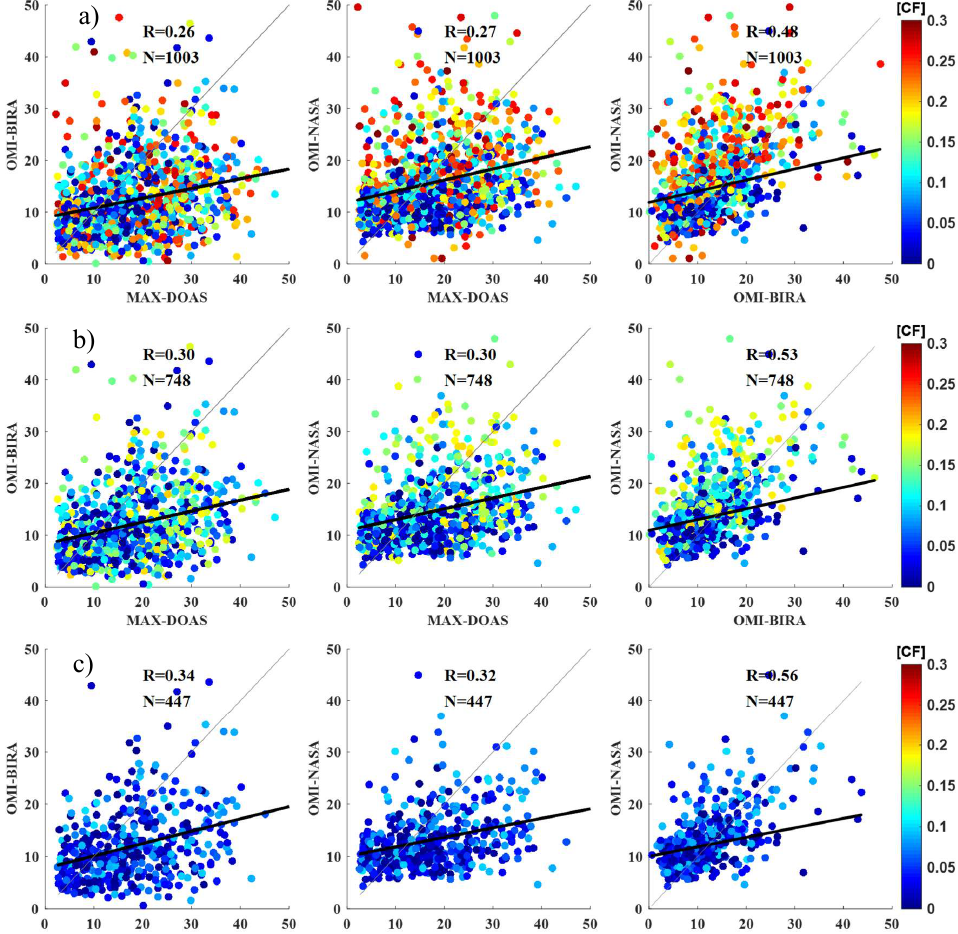
Figure 3. Daily comparisons of OMI-BIRA and MAX-DOAS, OMI-NASA and MAX-DOAS, and OMI-NASA and OMI-BIRA: ( a ) 0 ≤ eCF ≤ 30%, ( b ) 0 ≤ eCF ≤ 20%, ( c ) 0 ≤ eCF ≤ 10%. Figure A1 to Figure A3 show daily comparisons between OMI-BIRA and MAX-DOAS, OMI-NASA and MAX-DOAS, and OMI-NASA and OMI-BIRA by season. Figure A1 shows that the correlation between OMI-BIRA and MAX-DOAS is the best in spring, with R = 0.25 (R = 0.26) for 0 < eCF < 0.2 (0 < eCF < 0.1). The changes in eCF can change the correlation between the satellite data and the MAX-DOAS observations when the upper limit of eCF changes from 0.3 to 0.2 for all seasons except winter; however, less variation is observed for stricter cloud screening (eCF < 0.1) for summer. In winter, there is a weak correlation or even a negative correlation between OMI-BIRA and MAX-DOAS, indicating that the winter satellite data need to be used cautiously. Figure A2 shows that OMI-NASA has a better correlation with MAX-DOAS in spring. When stricter eCF control is employed, the satellite dataset’s correlation with the ground observations can be improved for spring and summer, but the two datasets have a poor correlation in summer and winter. OMI-NASA and OMI-BIRA have similar correlations except for winter, with R values ranging from 0.25 to 0.48 for eCF < 0.3 (Figure A3). The differences in dependence on eCF of OMI-BIRA and MAX-DOAS, OMI-NASA and MAX-DOAS, and OMI-BIRA and OMI-NASA will be discussed in Section 4. 3.2. Monthly Comparisons